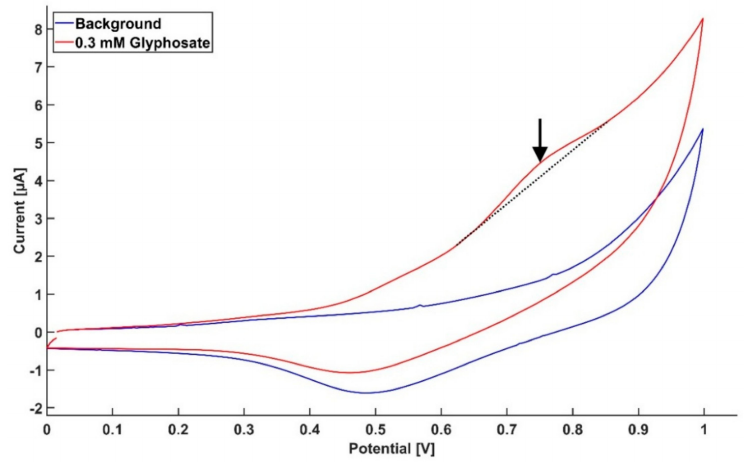
Figure 5. Cyclic voltammogram profile for a ground water sample spiked with Gly, with a final concentration of 0.3 mM. The graph shows a clear response from Gly compared to the un-spiked sample at the expected potential range. The sample was used directly after extraction with no further